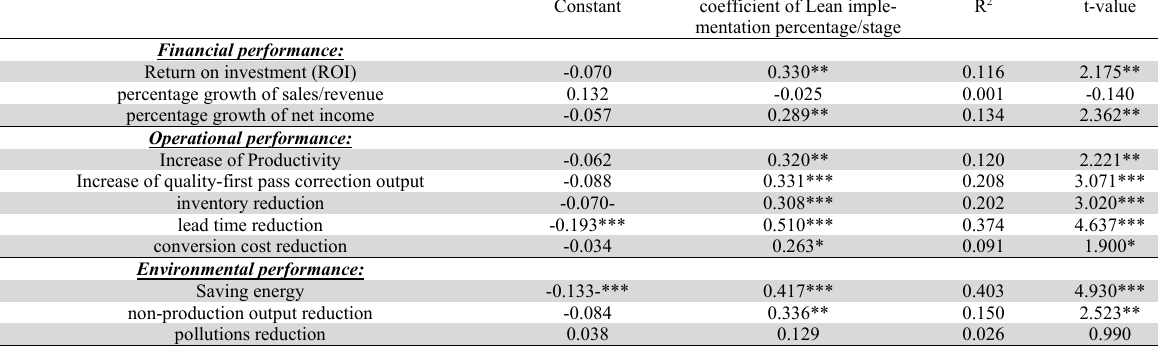
Simple regression results between the lean and performance